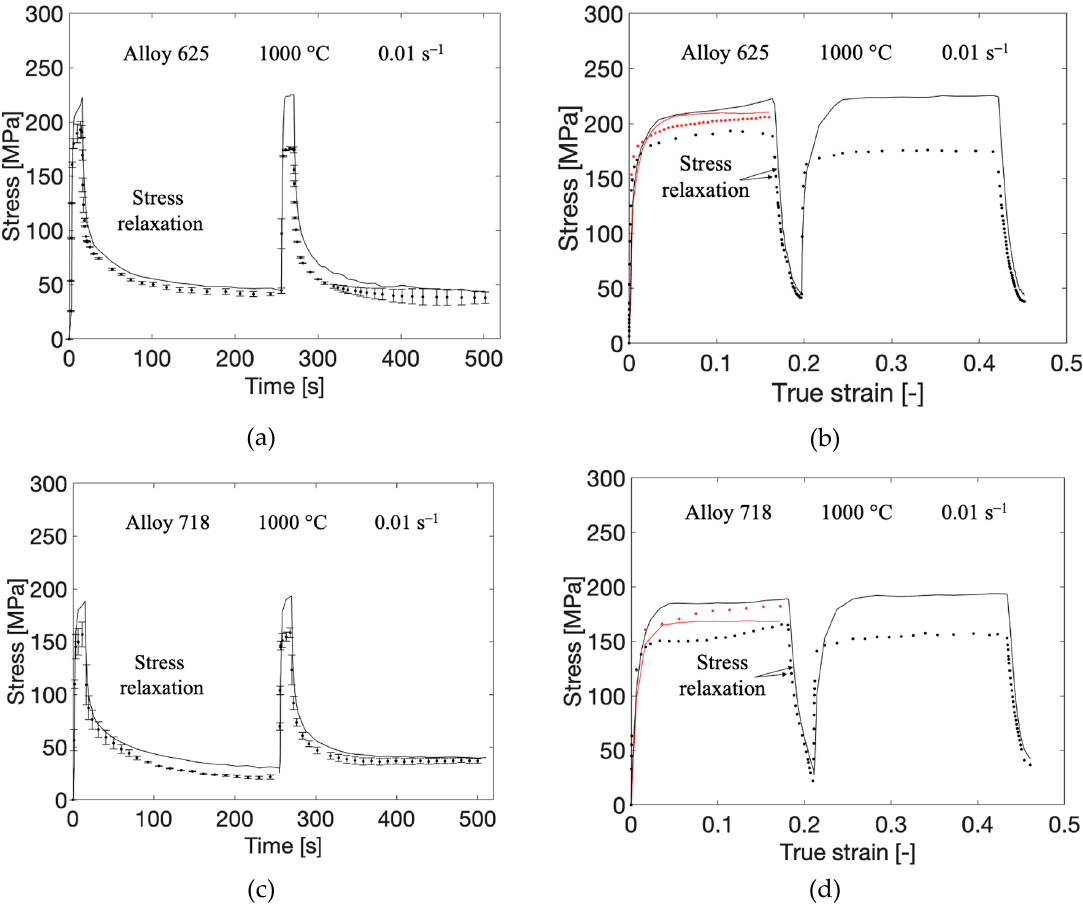
Figure 4. Measured (discrete points) and computed (solid lines) stress relaxation tests for alloy 625, shown in ( a , b ), and alloy 718, shown in ( c , d ). ( a , c ) include errorbars for the measured curves. In ( b , d ), the ordinary compression tests from the calibration sets are included. The difference in stress level of the modeled curves in the first sequence is because of variations in strain rate in the experiments.